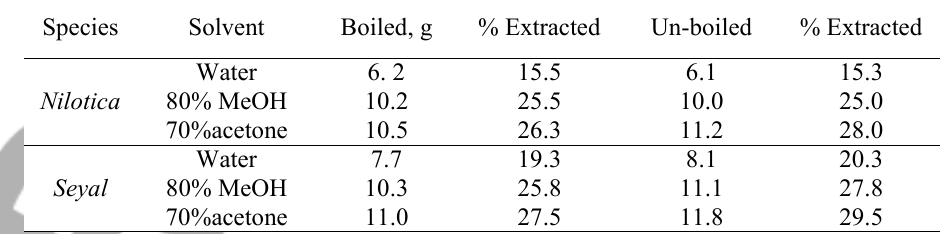
Table 1. Total extractives from acacia species samples with water, 80 Methanol, and 70%